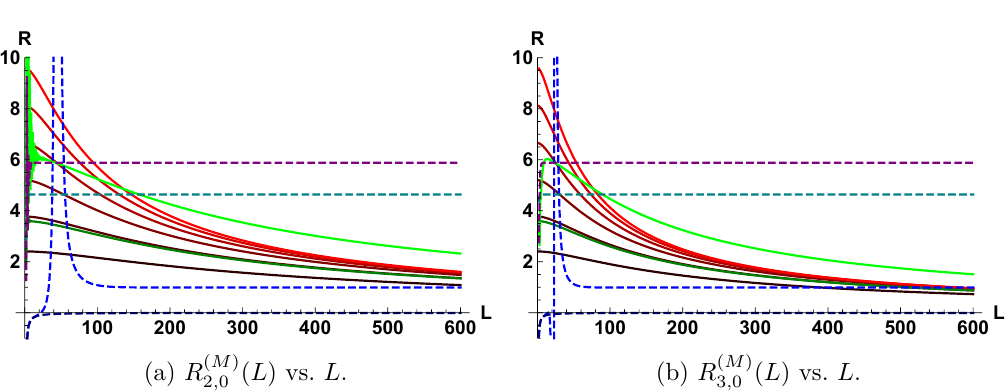
Figure 9. Mass multipole ratios with M 0 in the numerator: R ( M )